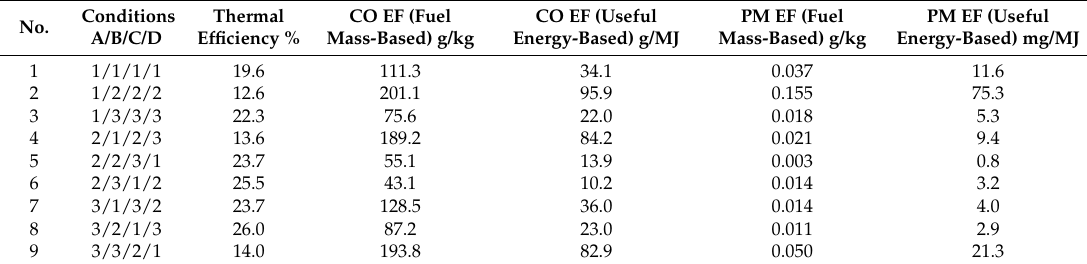
Table 3. Results of orthogonal tests.